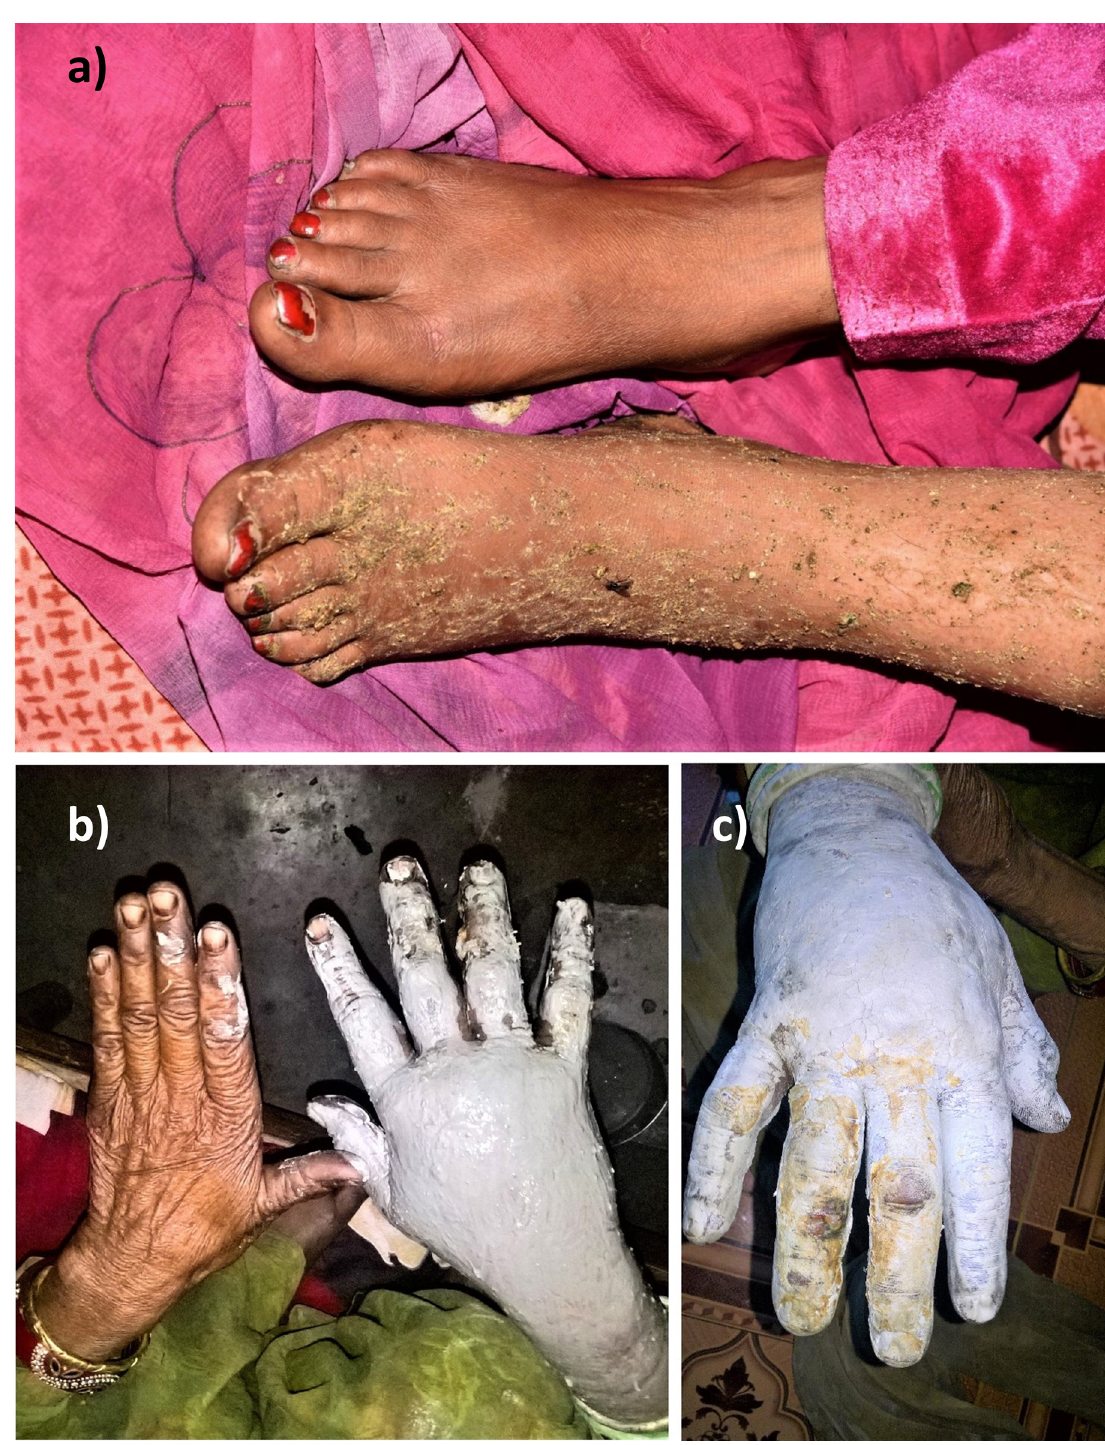
Fig. 10. Examples of bites from Gloydius chambensis sp. nov. a . Female victim bitten on the little toe of her left foot, while walking through long grass to collect drinking water, with visible swelling. b–c . Elderly woman, bitten on the ring finger of her right hand while cutting long grass for cattle fodder, with swelling, localized pain, and tenderness immediately after the bite. After 24 hours, there were signs of infection at the bite site with reduced swelling. The substances on the leg of the first victim and the white substance on the hand of the second victim were applied by a local faith